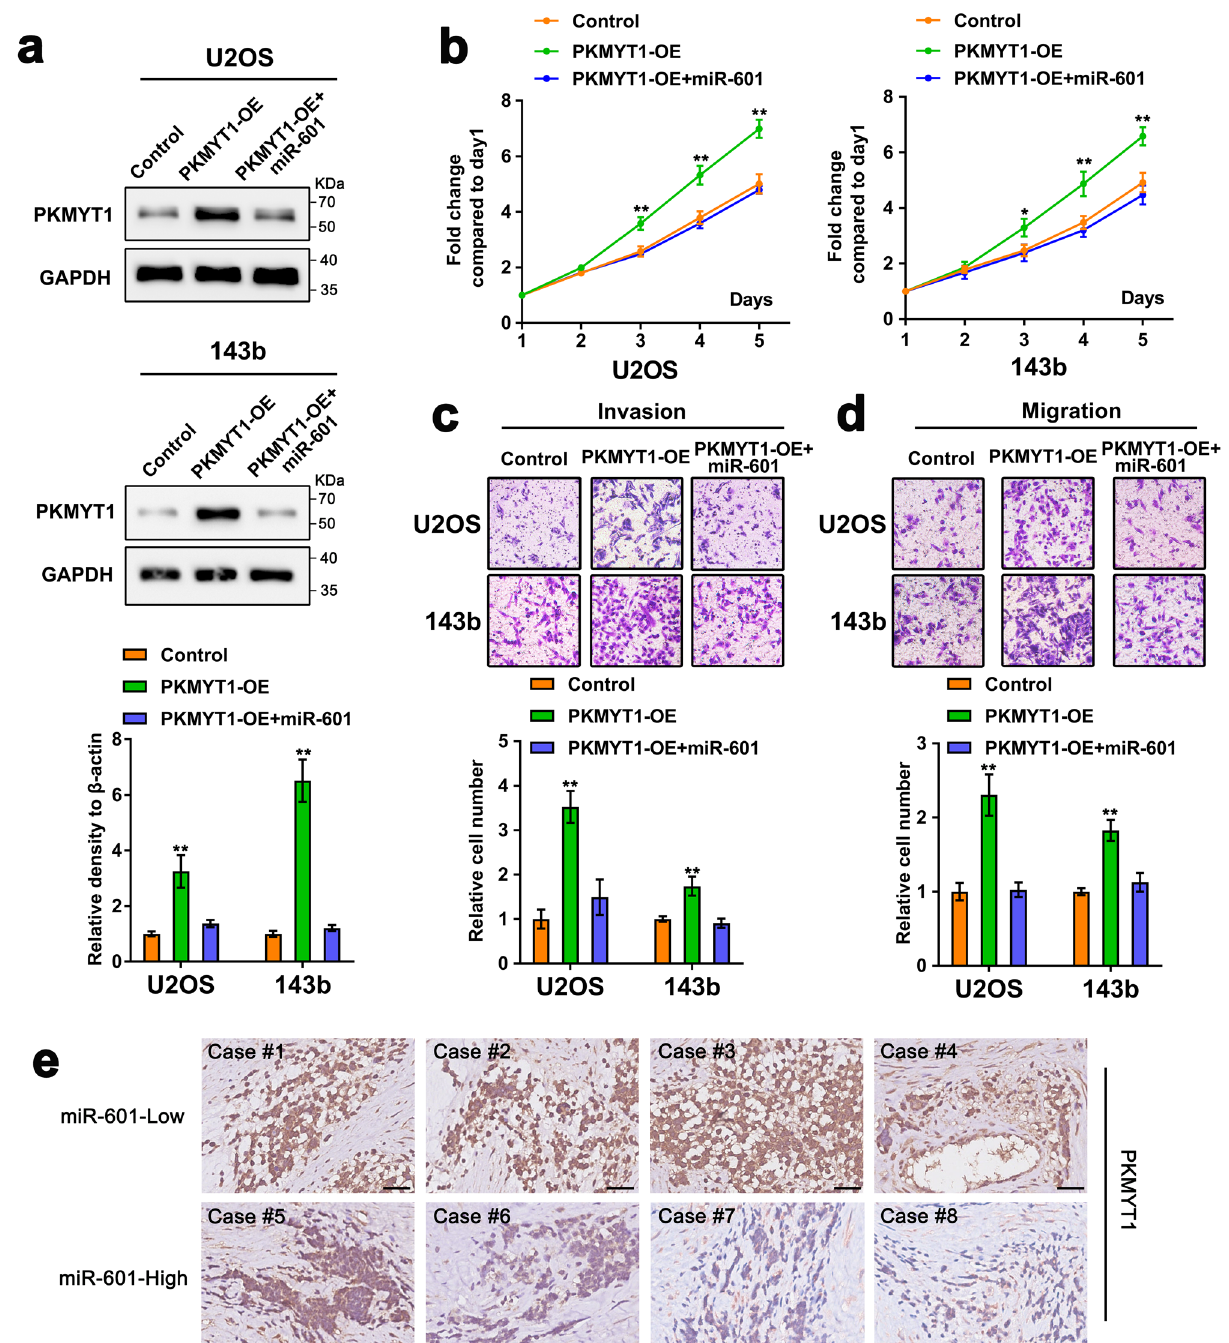
Figure 4. miR-601 exerts its tumor suppressor function in OS by targeting PKMYT1. ( a – d ) U2OS/143b cells were transfected with PKMYT1 overexpression plasmid, miR-601 mimic or negative control. ( a ) The protein level of PKMYT1 were detected by Western blot assay in U2OS and 143b cells. The original blots/gels are presented in Supplementary Dataset File. ( b – d ) MTT and transwell assays assess the proliferation, invasion and migration of U2OS and 143b cells. ( e ) IHC assay detected the PKMYT1 protein expression in OS tissues with miR-601-low and miR-601-high. Scale bar: 100